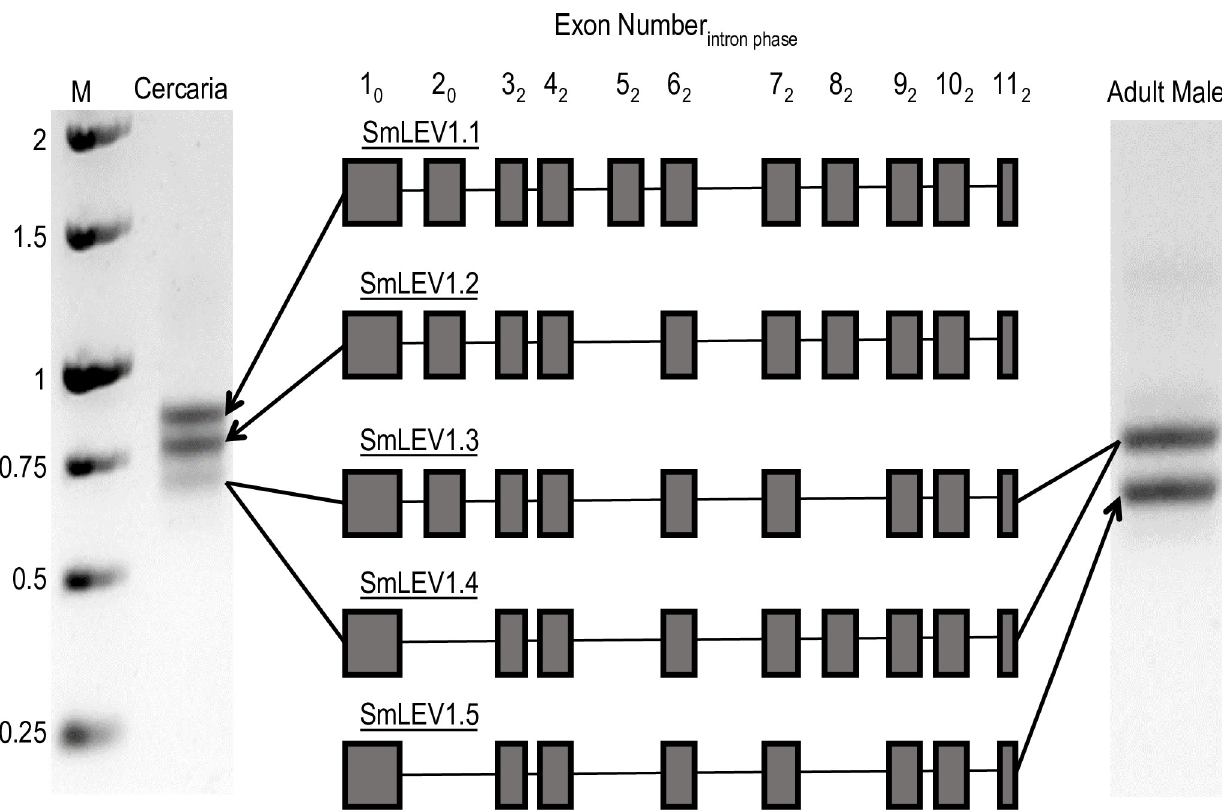
Fig 1. smlev1 exhibits cassette-based alternate splicing. PCR amplification of smlev1 from cercarial and adult worm cDNA revealed the full-length, genome prediction ( smlev1 . 1 ) in addition to four shorter splice variants ( smlev1 . 2—smlev1 . 5 ). smlev1 . 1 (full length) = 891 bp, smlev1 . 2 = 810 bp, smlev1 . 3 = 726 bp, smlev1 . 4 = 702 bp, smlev1 . 5 = 618 bp. Shaded boxes represent exons present in the transcript; the exon number and subscript 3 0 intron phase of each exon is indicated in the rubric. M = 1 Kbp ladder, sizes in Kilo base pairs.